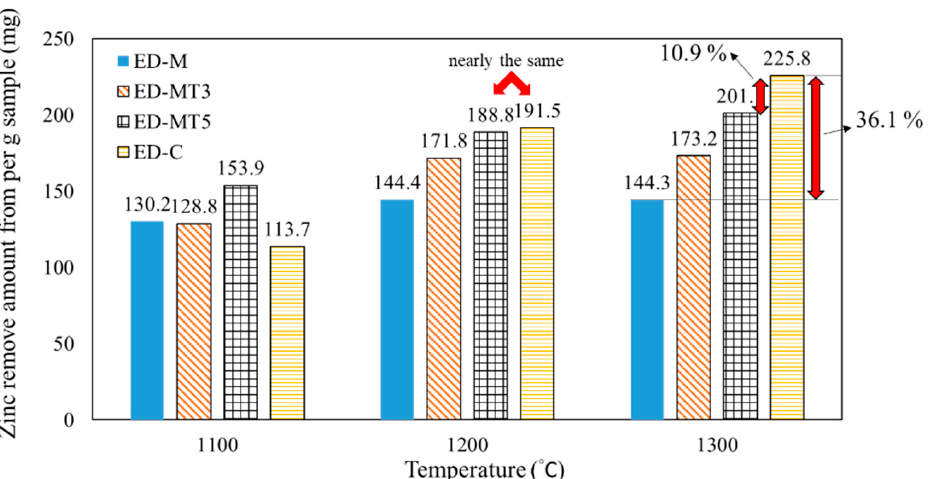
Figure 3. Zn productivity (C/O ratio = 0.8) per gram SMS-based and coke-based pellet samples at different interrupted temperatures (1100 °C, 1200 °C, and 1300 °C) for carbothermic reduction.